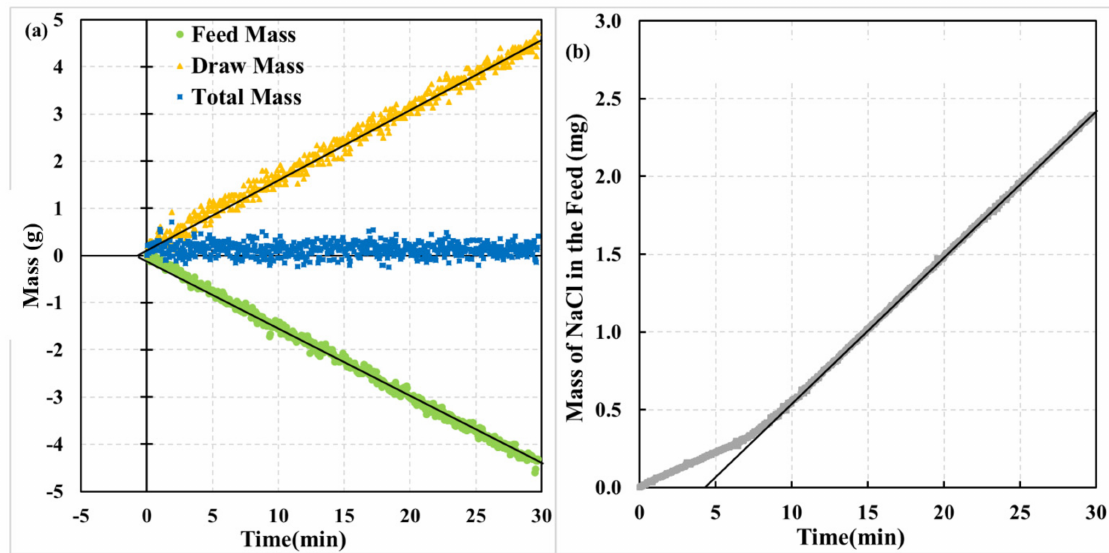
Figure 4. Summary of an FO experiment; step change in the draw solution concentration of NaCl from 0 to 2 M/L; experiment carried out at 25 ± 0.3 ◦ C; ( a ) mass of the feed, draw, and feed + draw as a function of time; ( b ) mass on NaCl in feed solution as a function of